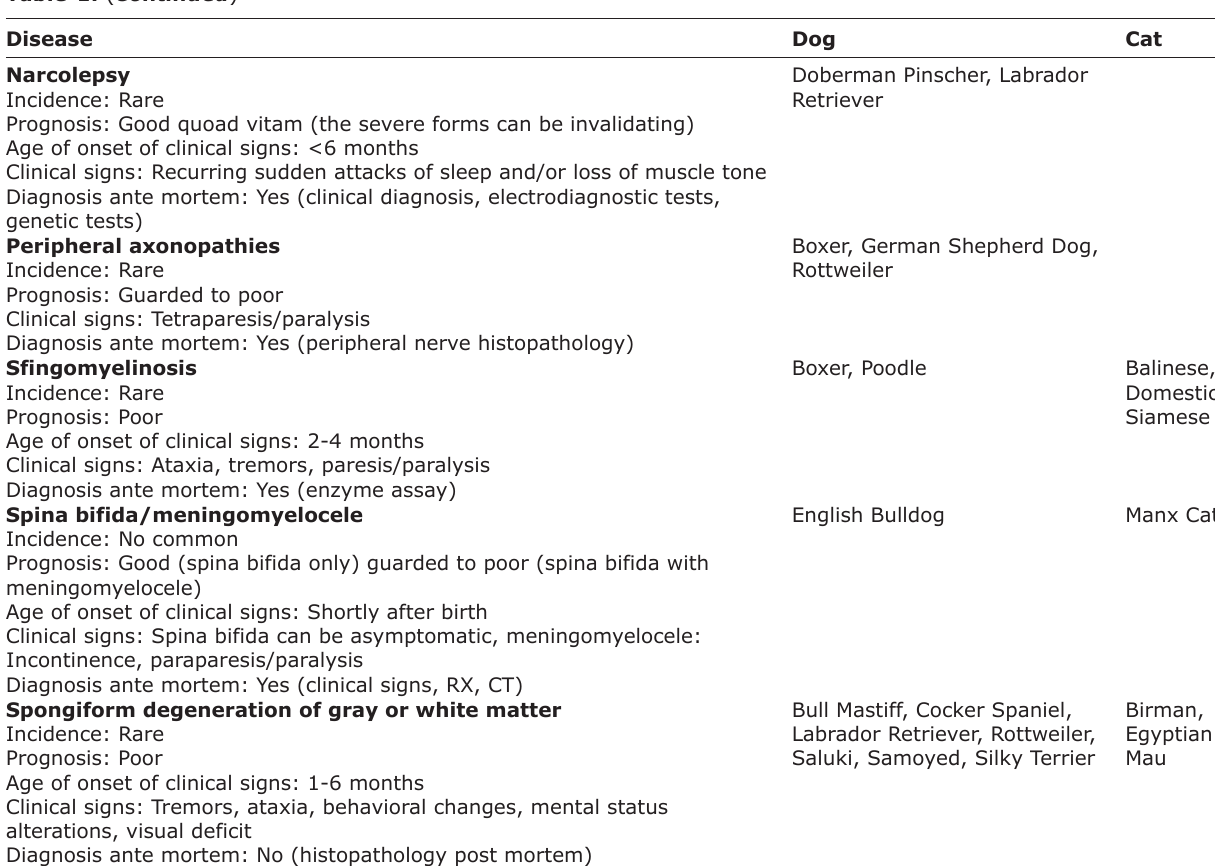
Disease Dog Cat Narcolepsy Incidence: